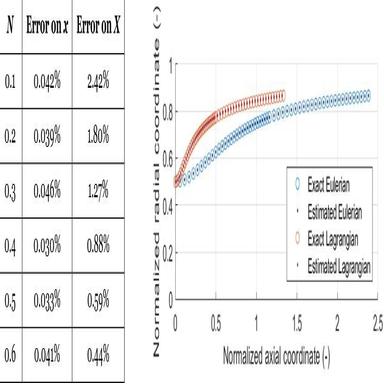
Results of the iterative procedure to determine the initial position of some sampling points. The table presents the error on x and the error on X. The plot shows the following profiles for the case N = 0.3: exact Eulerian xi ð Þ ;ri , estimated Eulerian x i;ri , exact Lagrangian Xi ð Þ ;ri , estimated Lagrangian X i;ri ; the coordinates are normalized with respect to the initial radius.q: